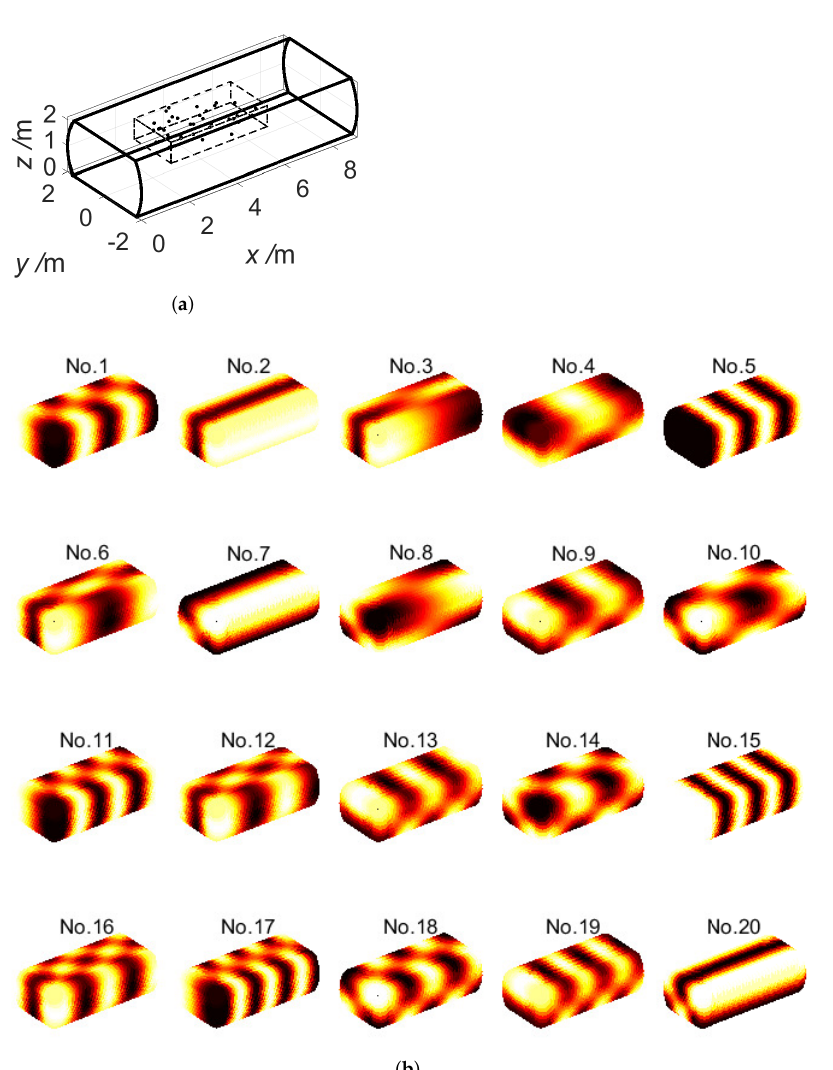
Figure 6. (Color online) ( a ) Geometry of the enclosure, with the dashed box denoting the virtual parallelepiped and the black dots representing the randomly distributed samplings. ( b ) Desired mode shapes of the 20 modes around 107.5 Hz.